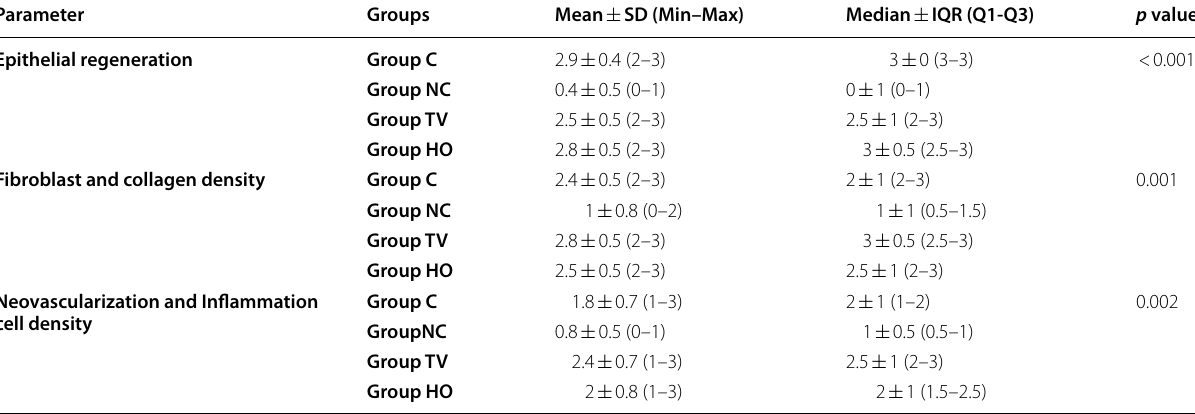
p values show the results of the Mann–Whitney U test Results were evaluated at a significance level of p <